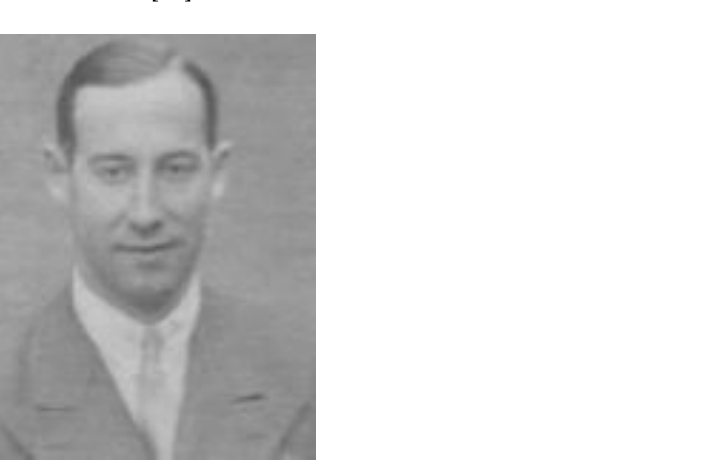
Figure 7. Ernst Carl Gerlach Stueckelberg in 1934 at London International Conference on Physics. Taken from